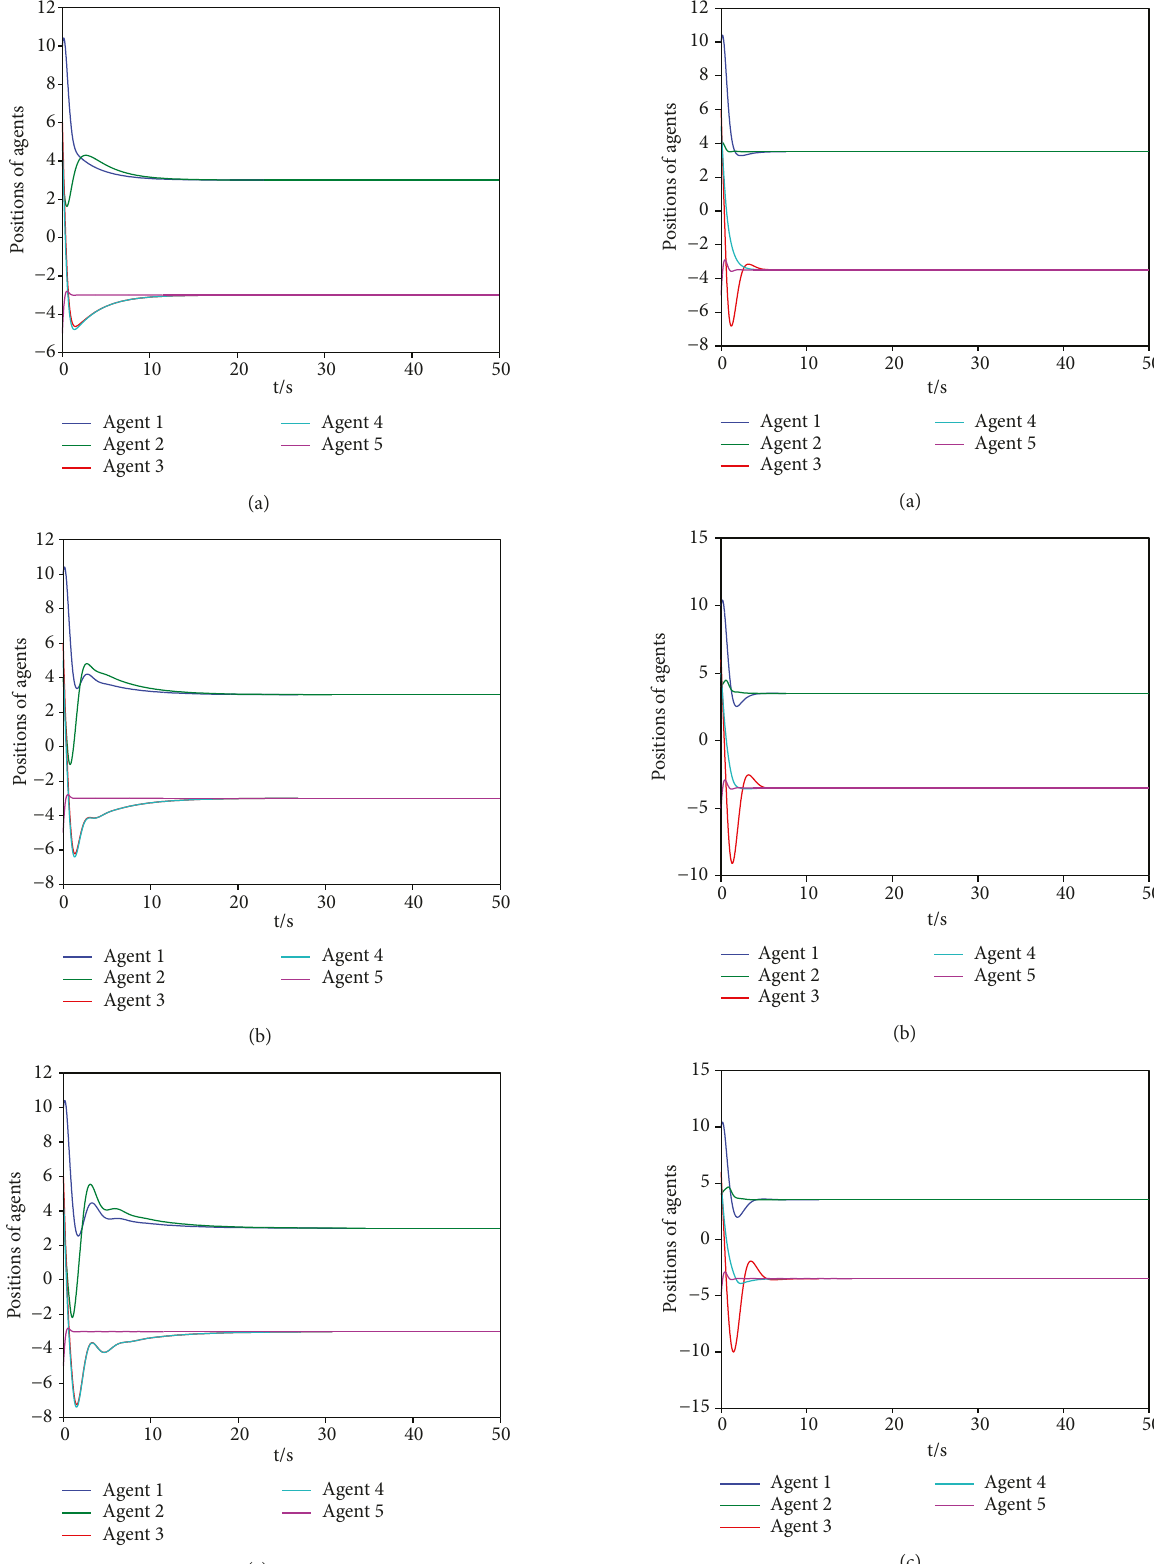
Figure 8: The agents ’ position trajectories, where τ τ = 0 5 , τ = 0 25 , and τ 3 4 τ = 0 8 ij